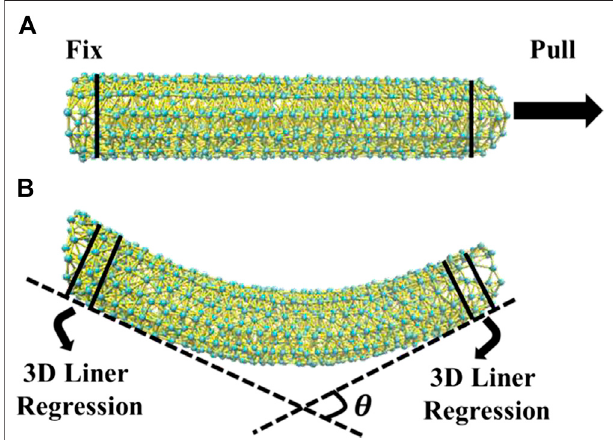
FIGURE 2 | (A) An illustration of force-clamped MD simulation for measuringYoung ’ smodulusofmicrotubule. (B) Theestimationofpersistence length using a method of 3D linear regression based on thermal fl uctuation.